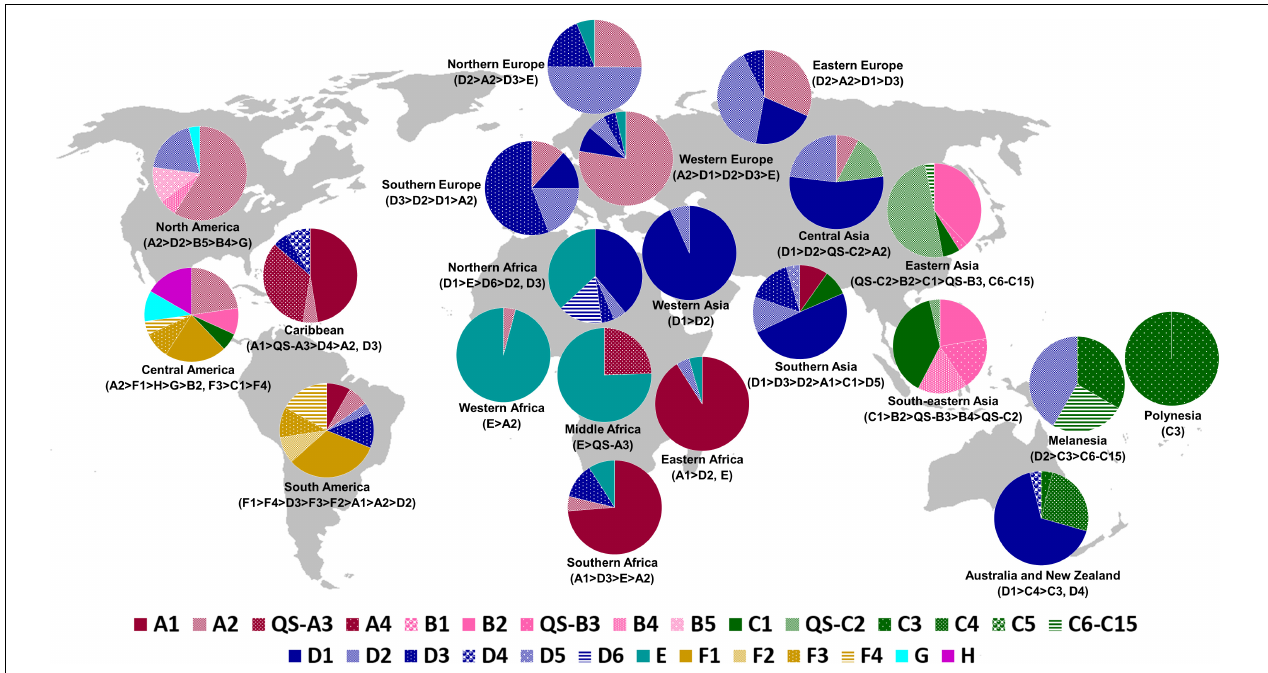
FIGURE 2 | Geographic distribution of HBV genotypes and subgenotypes based on 6,137 complete genome sequences present in the HBVdb database. (Sub)genotypes with frequencies < 3% were not included in the figure. The map was reconstructed using Wikimedia Commons (https://commons.wikimedia.org/wiki/File:BlankMap-World-noborders.png), this figure is similar but not identical to the original image and is therefore for illustrative purposes only. QS,